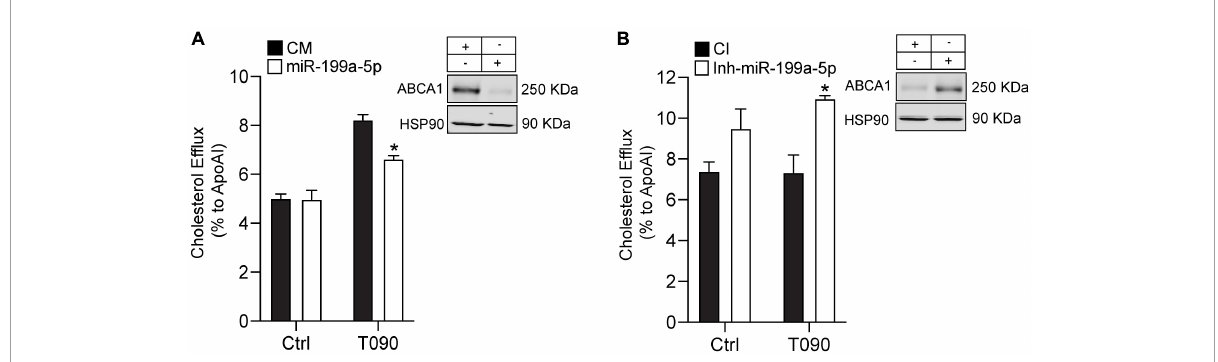
FIGURE8 MiR-199a-5p inhibits cholesterol efflux. (A,B) Cholesterol efflux analysis to ApoA1 performed in mouse peritoneal macrophages transfected with Ctrl-miR (CM) and miR-199a-5p or Ctrl-Inh (CI) or Inh-miR-199a-5p and stimulated with or without T0901317 (T090) 3 µ m for 12 h. Data are the means ± SEM of three independent experiments in triplicate. * P < 0.05 Ctrl-miR-199a-5p compared with miR-199a-5p or Ctrl-Inh-199 compared with Inh-miR-199a-5p. (A,B) Representative Western blots of ABCA1 in mouse peritoneal macrophages transfected with CM and miR-199a-5p or CI or Inh-miR-199a-5p. HSP90 was used as a loading control.